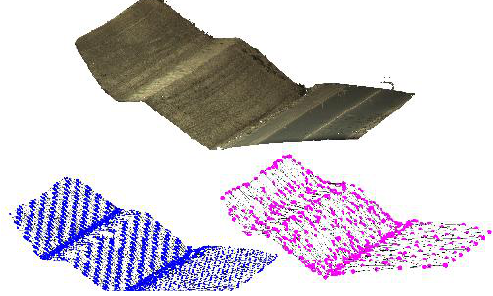
Figure 15. Slope planes comparing results